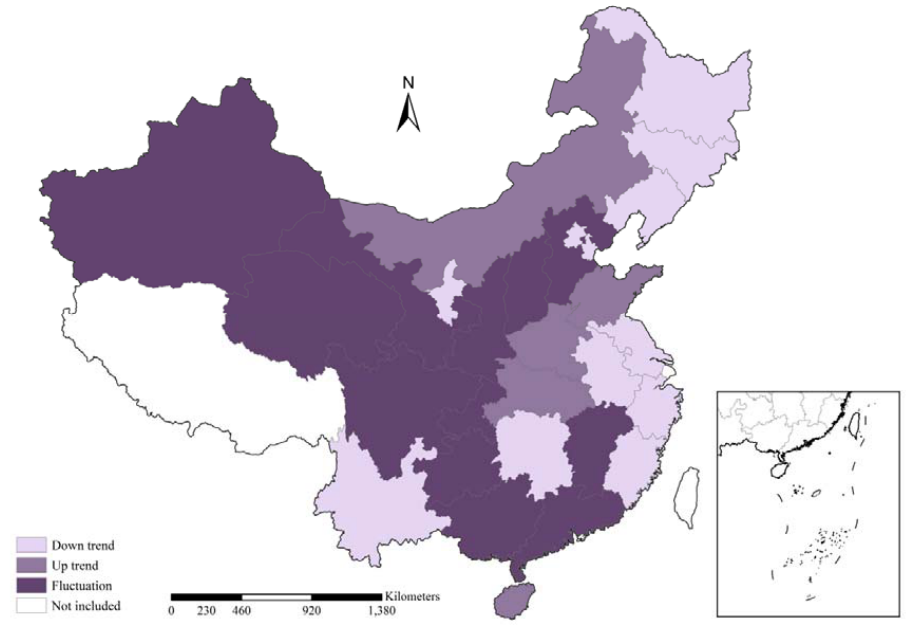
Figure 4. Changes of regional energy poverty situation in China. Note: It is a schematic map and does not imply definitive